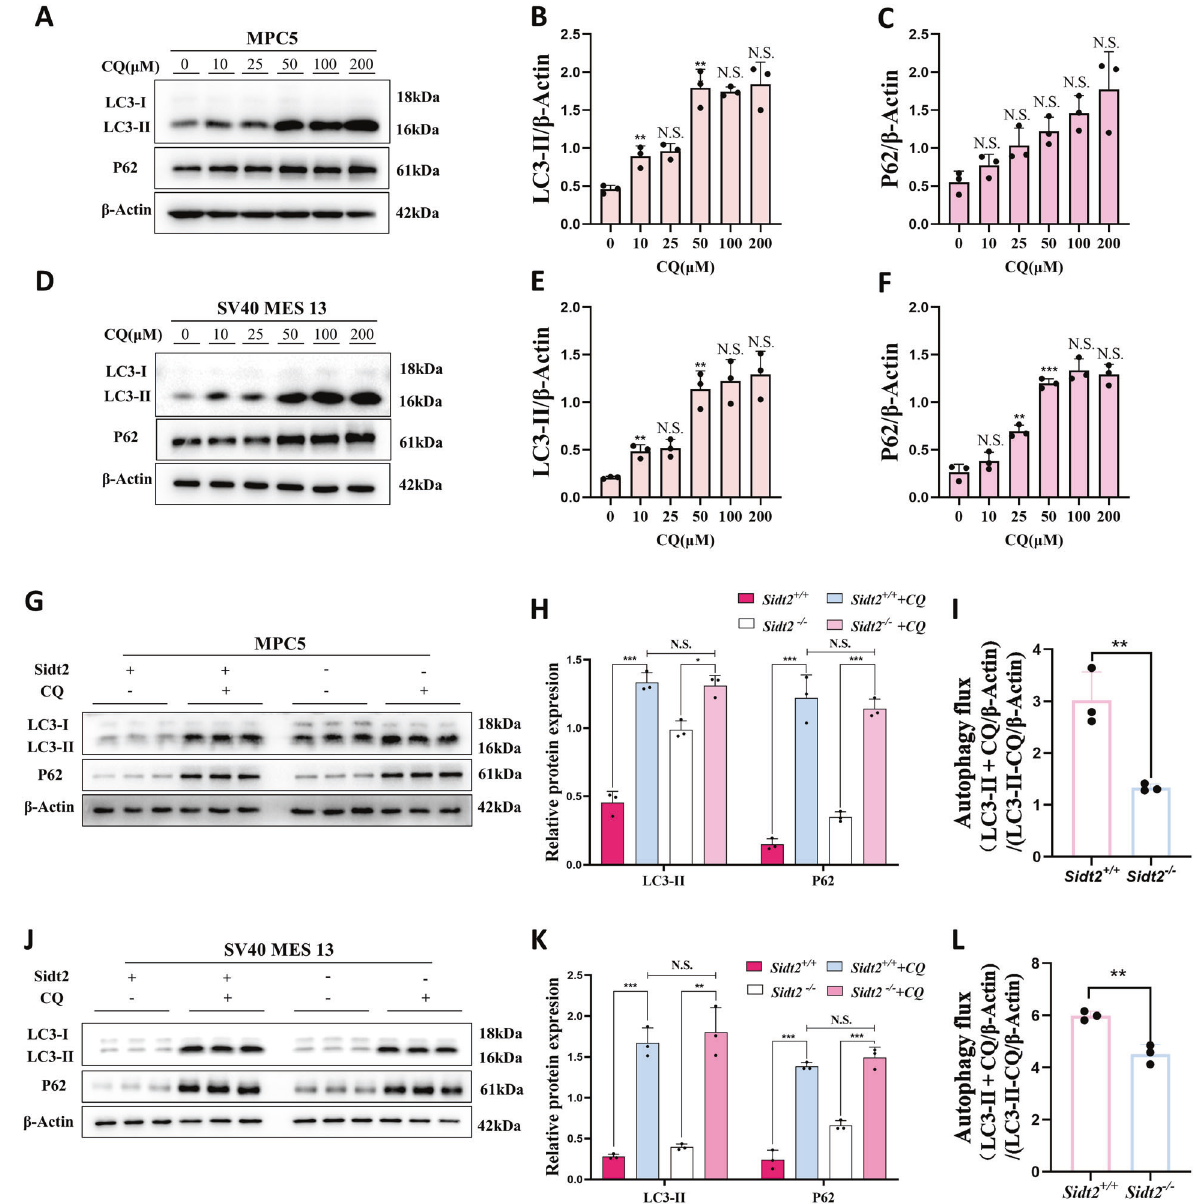
D SV40 MES 13 cell incubation for 16 h with 0, 10, 25, 50, 100, or 200 μ M CQ. Western blot shows LC3-II and P62 expression; E LC3-II statistical chart of SV40 MES 13 cells; F SV40 MES 13 cell P62 statistical chart; G determination whether CQ induces the expression of key autophagy proteins before and after Sidt2 knockout in MPC5 cells; H statistical chart of ( G ); I changes in the autophagy fl ux in MPC5 cells on Sidt2 knockout (LC3-II + CQ/ β -Actin)/(LC3-II − CQ/ β -Actin) (ref. [27]); J determination whether chloroquine induces the expression of key autophagy proteins before and after Sidt2 knockout in SV40 MES 13 cells; K statistical chart of ( J ); L changes of the autophagy fl ux in SV40 MES 13 cells on Sidt2 knockout (LC3-II + CQ/ β -Actin)/(LC3-II − CQ/ β -Actin) (ref. [27]). * P < 0.05, ** P < 0.01, *** P <